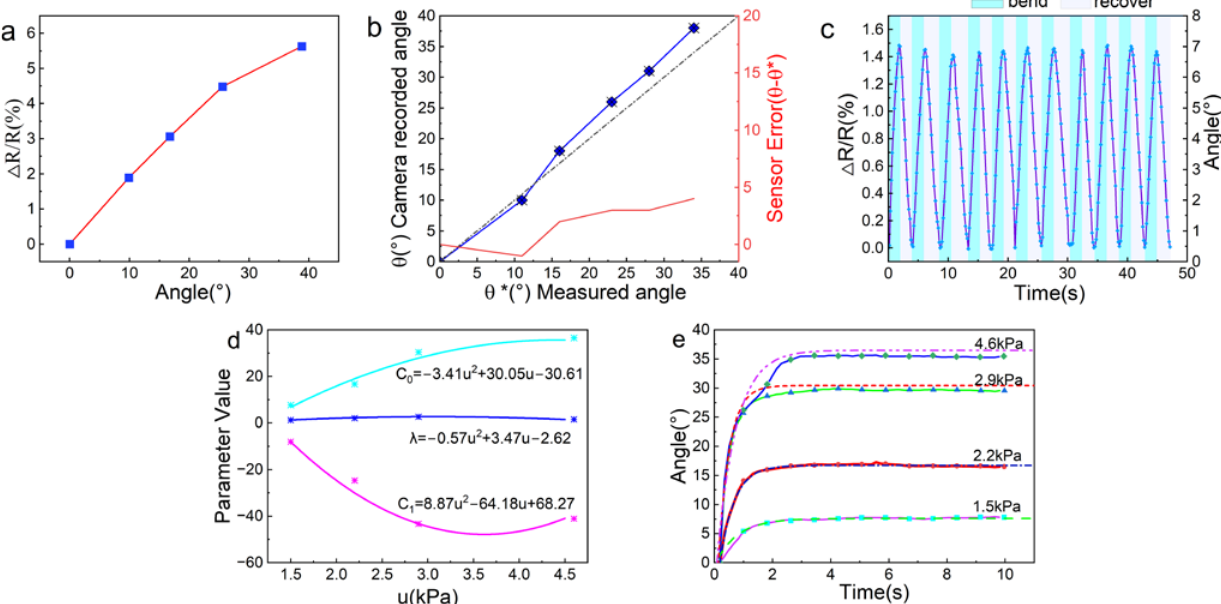
Figure 5. ( a ) The relationships between ∆ R/R and angles. ( b ) The actuator’s self-sensing angle versus the camera’s recorded angle. The asterisks represent the actuator’s self-sensing angles and the camera’s recorded angles under different pressure. The sensor’s error is also provided by subtracting the measured difference and is indicated by the solid red line. The dotted line represents angular consistency under ideal conditions. ( c ) The curves show the change of resistance and angles of the actuator during cycles of bending and recovery. ( d ) Fitted parameters versus pressures. ( e ) Comparison of the model’s prediction and the step responses of the soft actuator subjected to different input pressures. The dotted lines represent the model’s prediction. The solid lines indicate the experimental data.